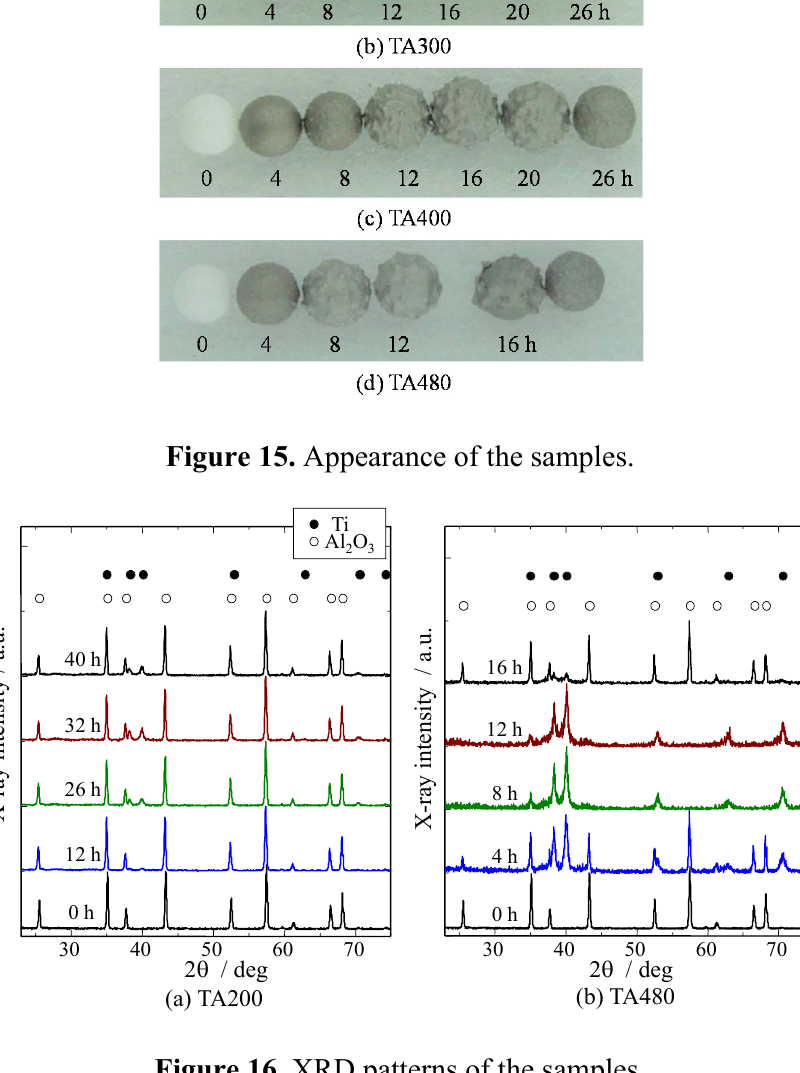
Figure 16. XRD patterns of the